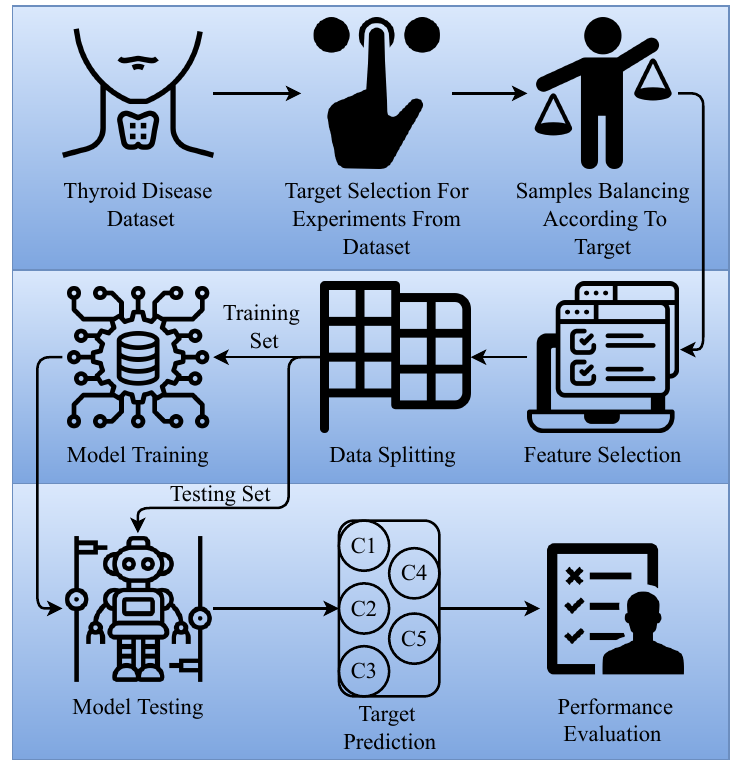
Figure 1. Flow of the proposed methodology.